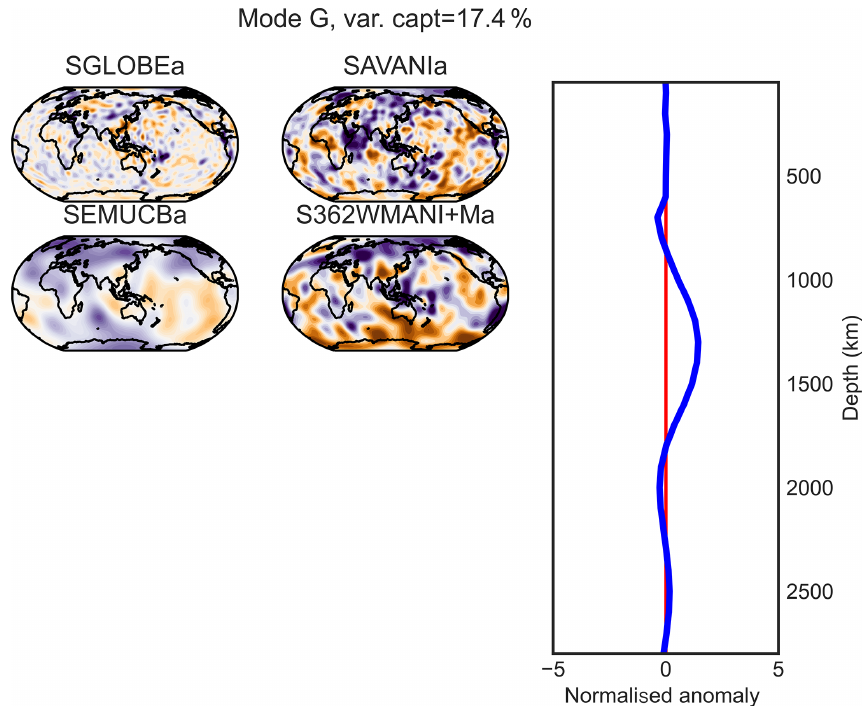
Figure E7. PC G (maximum at 1300km of depth) of the combined analysis of the anisotropic parts of the models.